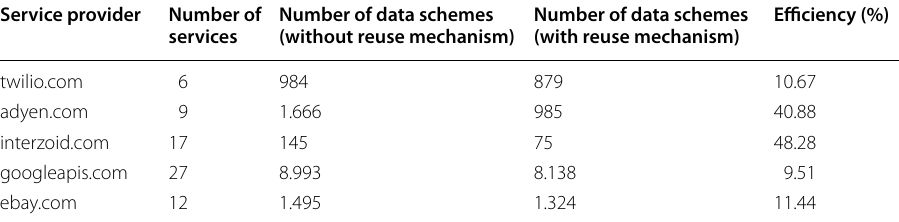
Table 9 Efficient use of data schemes per service